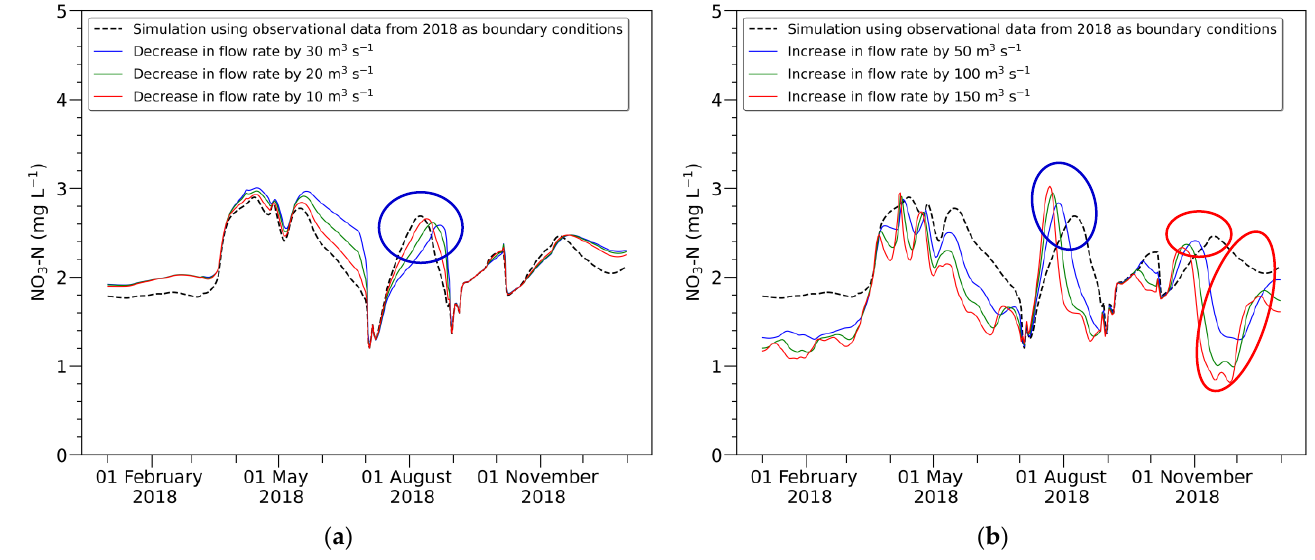
Figure 8. Changes in the NO 3 -N concentration in cross section 416 caused by variations in flow rate at the upstream boundary for 365 days. The black graph shows the NO 3 -N concentration simulated using the observational data from 2018 as boundary conditions. The dispersion coefficient was automatically computed in HEC-RAS. ( a ) Changes in the NO 3 -N concentration by a decrease in flow rates (Scenarios 1 – 3); ( b ) changes in the NO 3 -N concentration by an increase in flow rates (Scenarios 4 – 6).